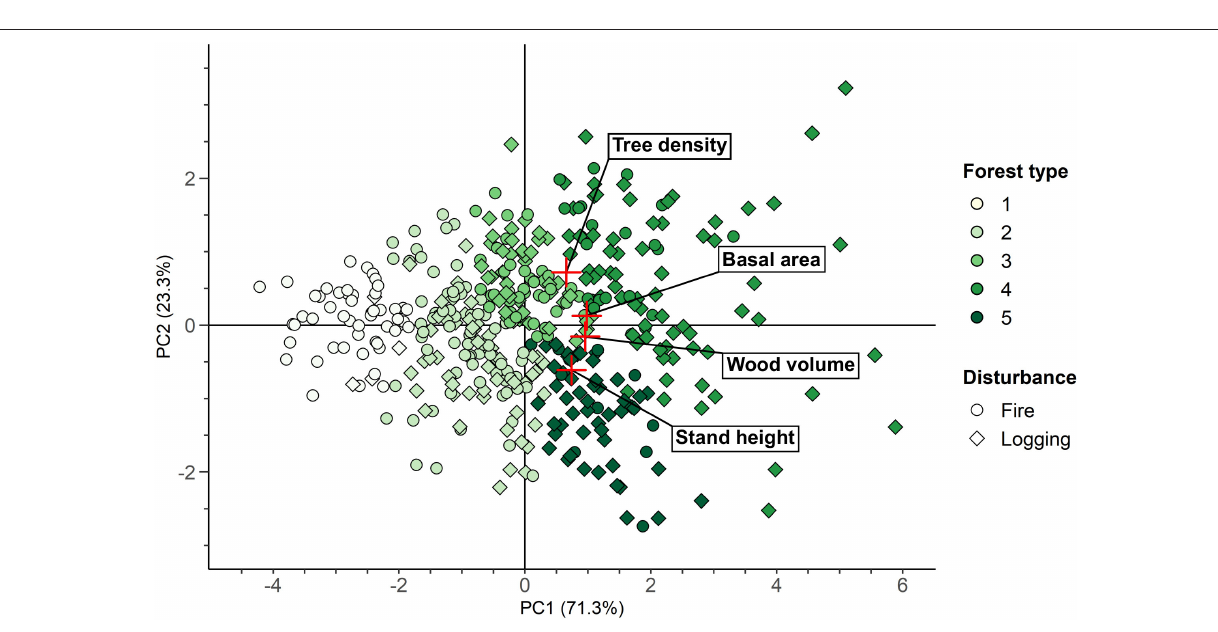
FIGURE 4 | Biplot of the PCA, presenting the transects studied according to the transect attributes considered for clustering, the forest types and the type of disturbance, on the two first axes of the PCA (PC1 and PC2, respectively). Numbers in brackets indicate the percentage of variance explained by each axis of the PCA, red crosses indicate the location of the transect